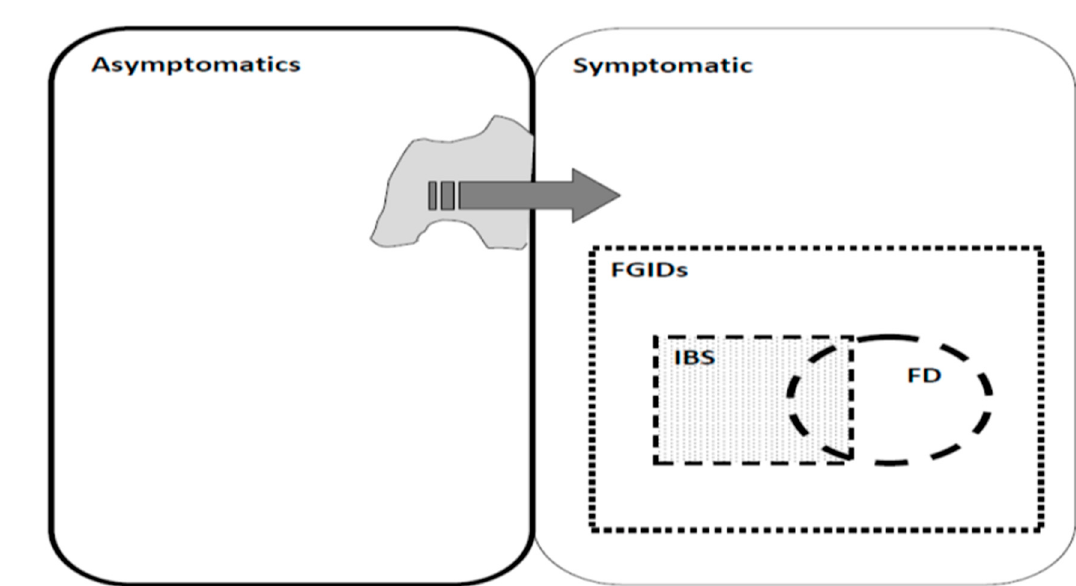
Figure 1. Control selection in Functional gastrointestinal disorders (FGID) with different approaches, Irritable bowel syndrome (IBS) and Functional dyspepsia (FD).